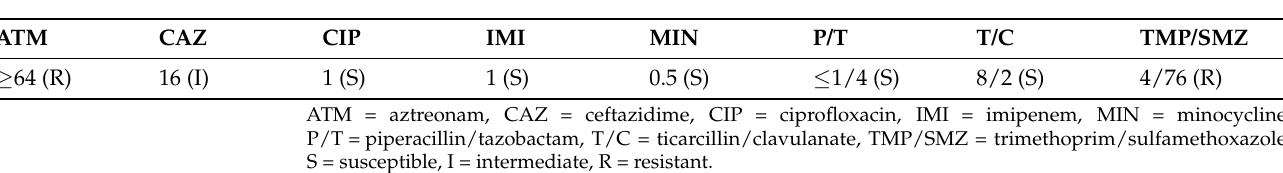
Table 1. Minimum inhibitory concentration (mg/L) and susceptibility interpretation of agents tested against Bordetella bronchiseptica isolated on day